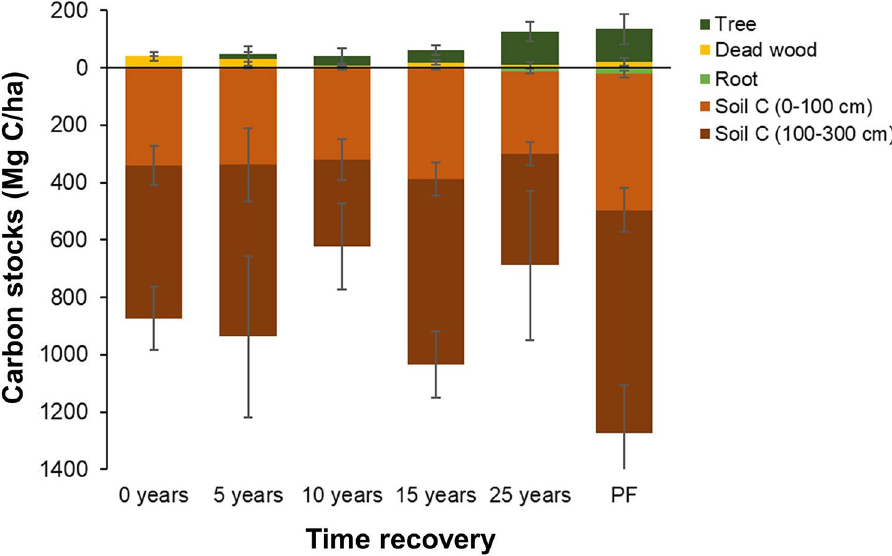
Figure 4. Total ecosystem carbon stock (TECS) variation across different ages of stands, representing the number of years of recovery, and protected forest (PF). Error bars indicate standard deviation of mean of respective carbon stock pool. Detailed sample size and site level carbon stocks data are provided in Table